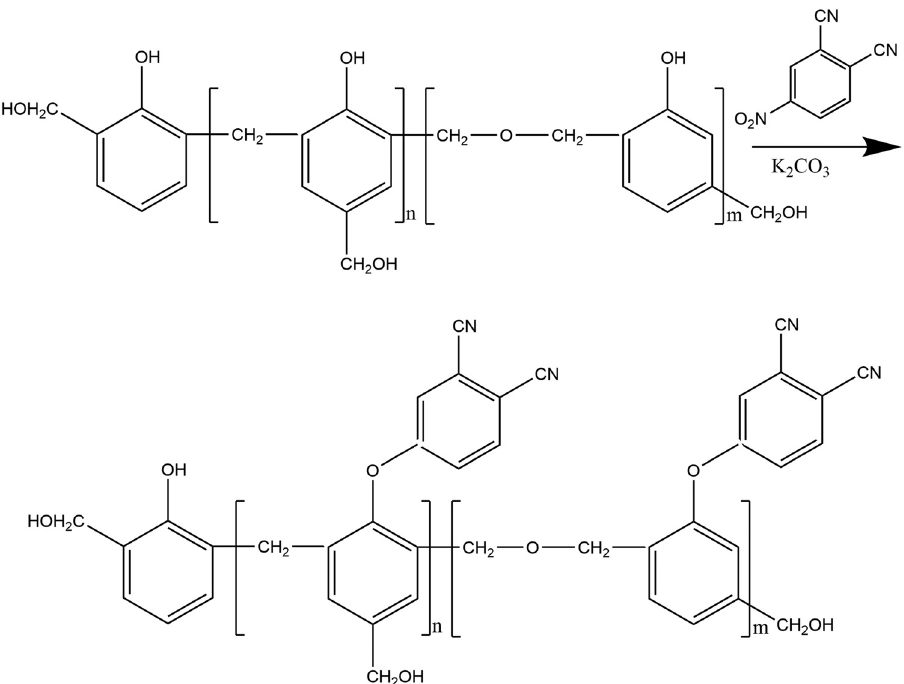
Figure 1: Synthesis of PNR.